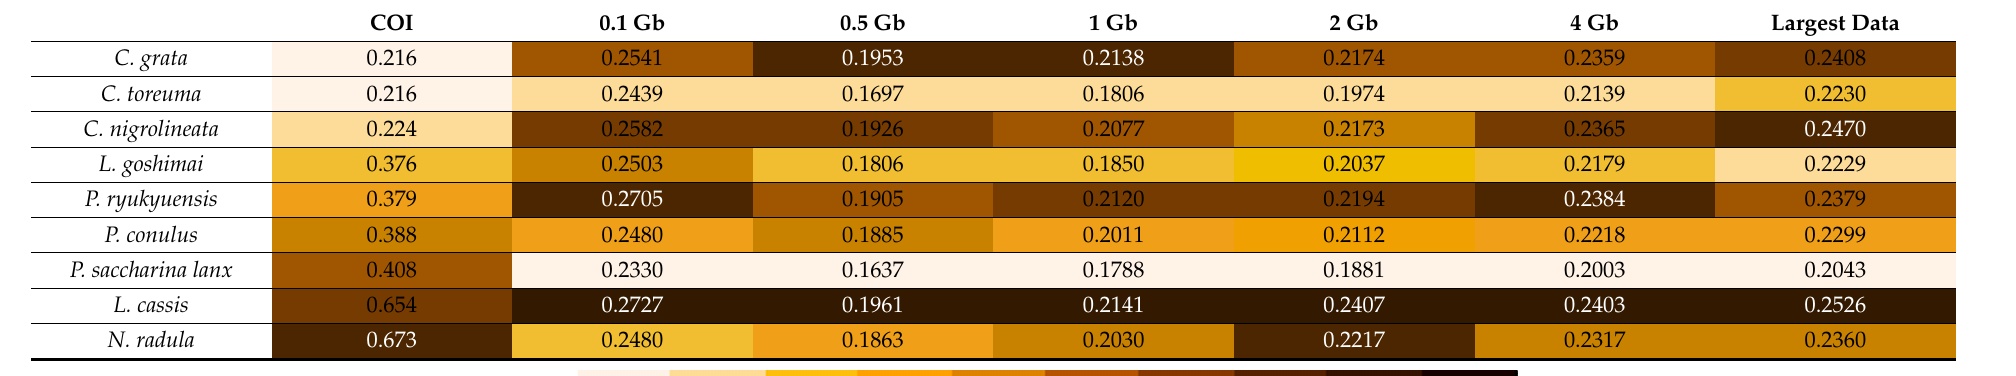
Color from light to dark: . Table 4. The calculation distance from COI and different sizes of genome skims between P. conulus and reference species in our study. Color shows the distance ranking between reference species and query species, that is, the darker the color, the farther the relationship.